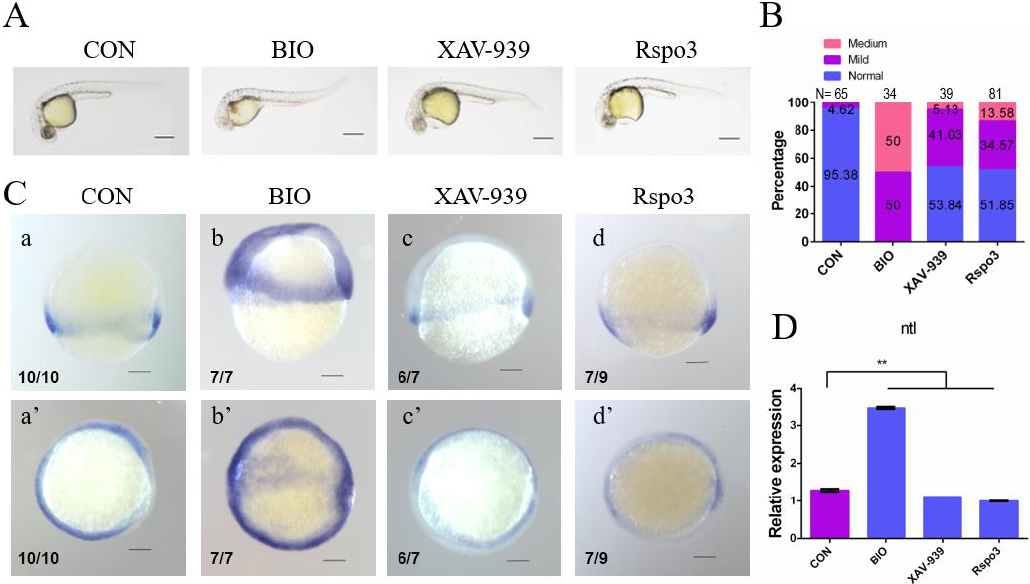
Figure 6. C. semilaevis Rspo3 affects mesoderm formation by regulating the Wnt/β-catenin signaling pathway. ( A ) AB strain D. rerio 24 hpf embryos after treatment with 0.15 μM BIO or 1.67 μM XAV-939, or microinjection with 1000 pg C. semilaevis Rspo3 mRNA per embryo. All embryos are shown oriented with anterior to the left. Scale bar = 200 μm; ( B ) Abnormality rates of embryos in each group as shown in ( A ), N is the number of total samples analyzed in each group; ( C ) WISH analysis of ntl at the gastrula stage in each group; a–d are lateral views, whereas a’–d’ are quarter views. Scale bar = 200 μm; ( D ) RT-PCR analysis of ntl at the gastrula stage in each group. β-actin is the reference gene. The data are shown as mean ± SD ( n = 3, N = 30). The superscript indicates statistical significance (** p < 0.01).